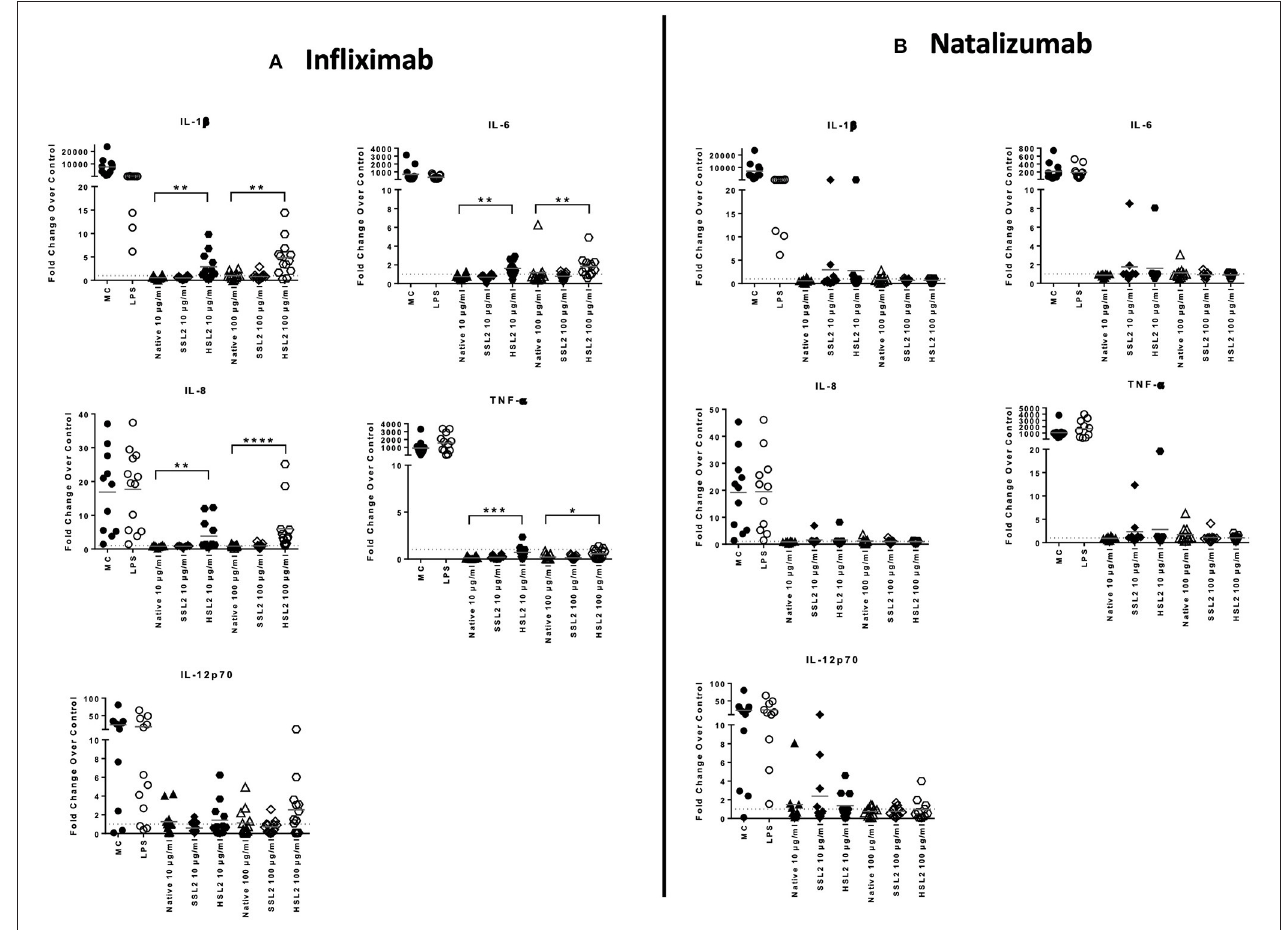
FIGURE 5 | Protein levels of proinflammatory cytokines in moDC following treatment with native or aggregated infliximab (A) and natalizumab (B) . Immature moDC were treated for 48h with native or stressed (SSL2 or HSL2) antibodies, or maturation cocktail (MC) or LPS. Cytokine concentrations were measured in culture supernatants using a MSD multiplex assay. Results are expressed as fold chage over PBS control. The results from 11 independent experiments are shown. * p < 0.05; ** p < 0.01; *** p < 0.001; **** p <